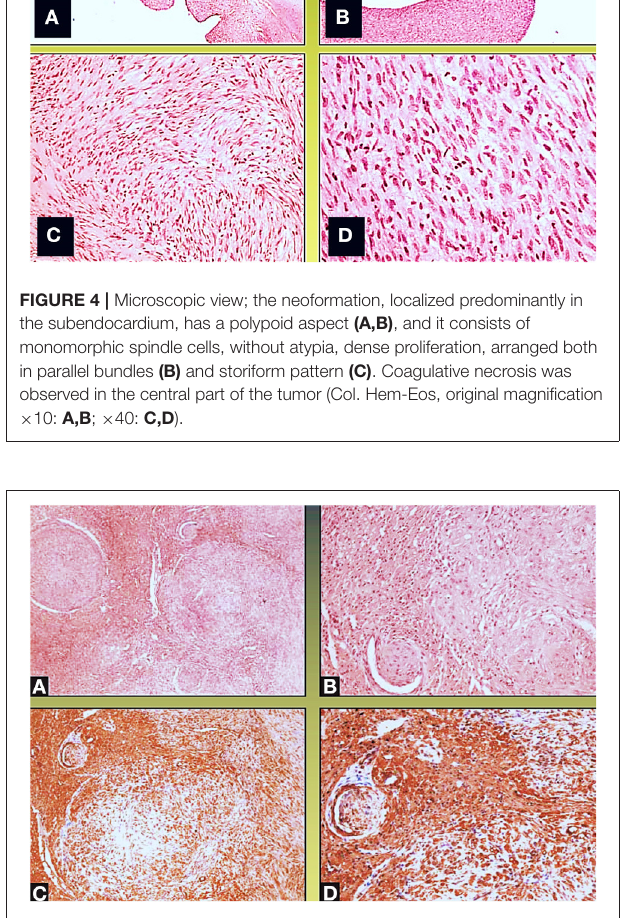
the contrary, consists of large spindle cells with nuclei